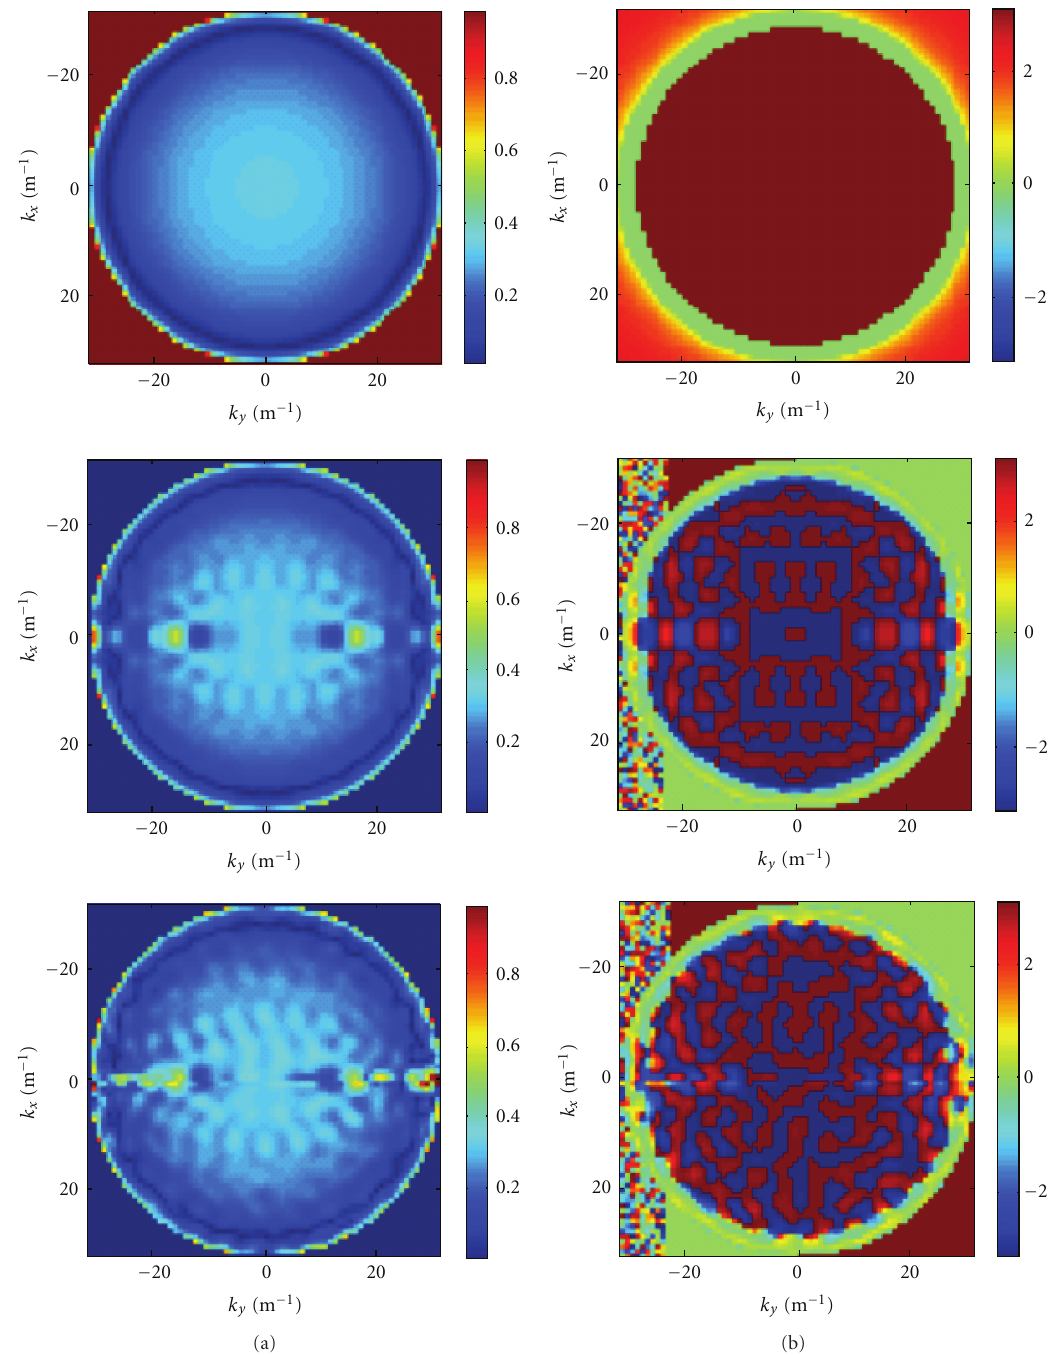
Figure 5: Soil 1. Amplitude (a) and phase (b) of Γ TM . Top line: actual values; middle line: noiseless estimation; bottom line: noisy